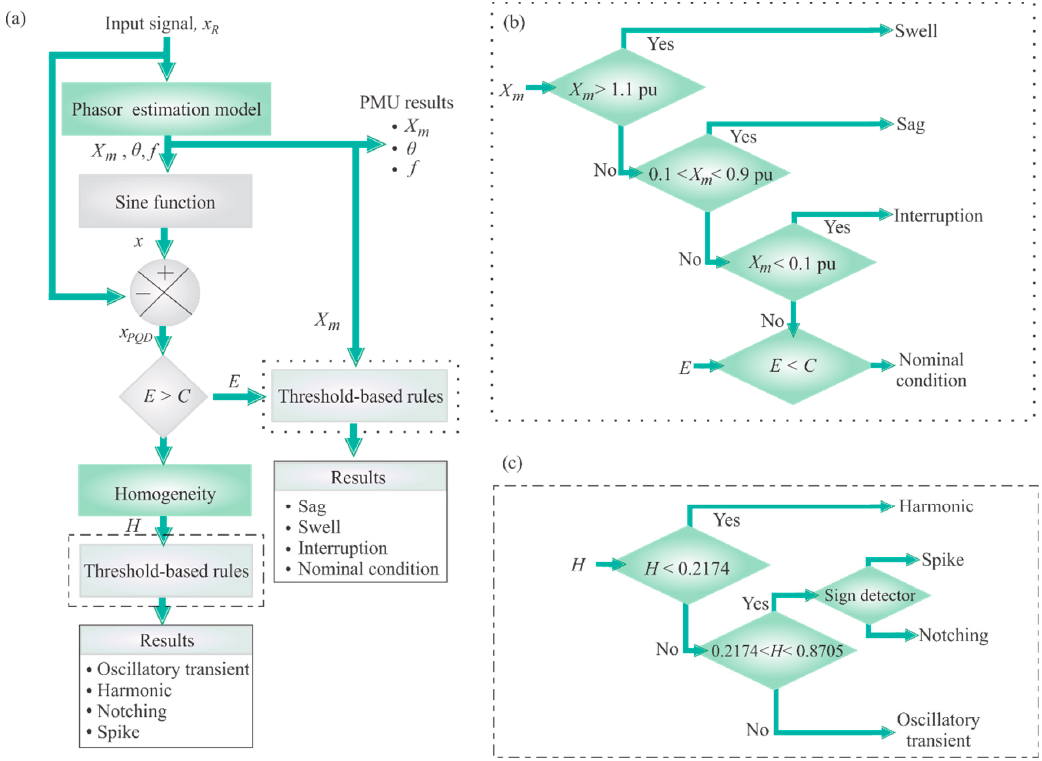
Figure 3. ( a ) Proposed methodology, ( b ) threshold-based rules for PQDs at the fundamental component, and ( c ) threshold-based rules for PQDs at the non-fundamental component.